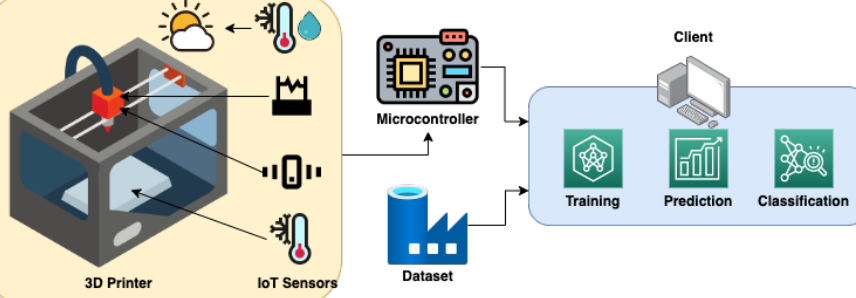
Figure 4. The FDM sensor-based fault monitoring framework involves the collection of data from collaborative IoT sensors and running them through a machine learning